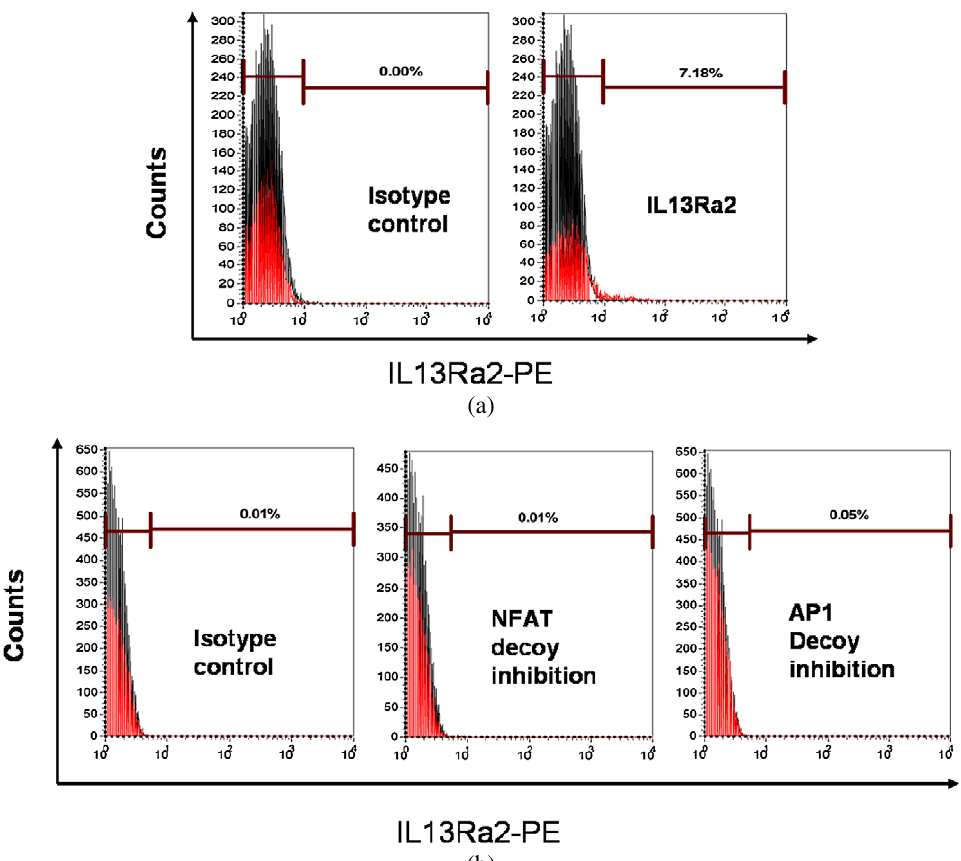
Fig. 2D. (a) Flow cytometric analysis of human IL-13Ra2 expression on K562 cells after the stimulation of PMA/iono. (b) The induction of human IL-13Ra2 expression on the surface of K562 cells was effectively inhibited by using NFAT or AP1 specific ODNs. Each histogram is representative of three independent evaluations. The flow cytometric analysis was performed using an anti-human IL-13Ra2 mAb and an isotype IgG as a